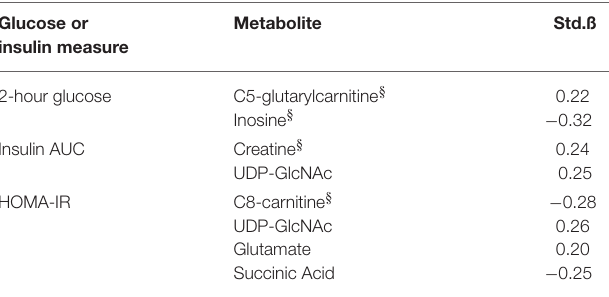
TABLE 4 | Independent associations between changes in metabolites, adiposity measures, and measures of glucose and insulin metabolism. Glucose or insulin